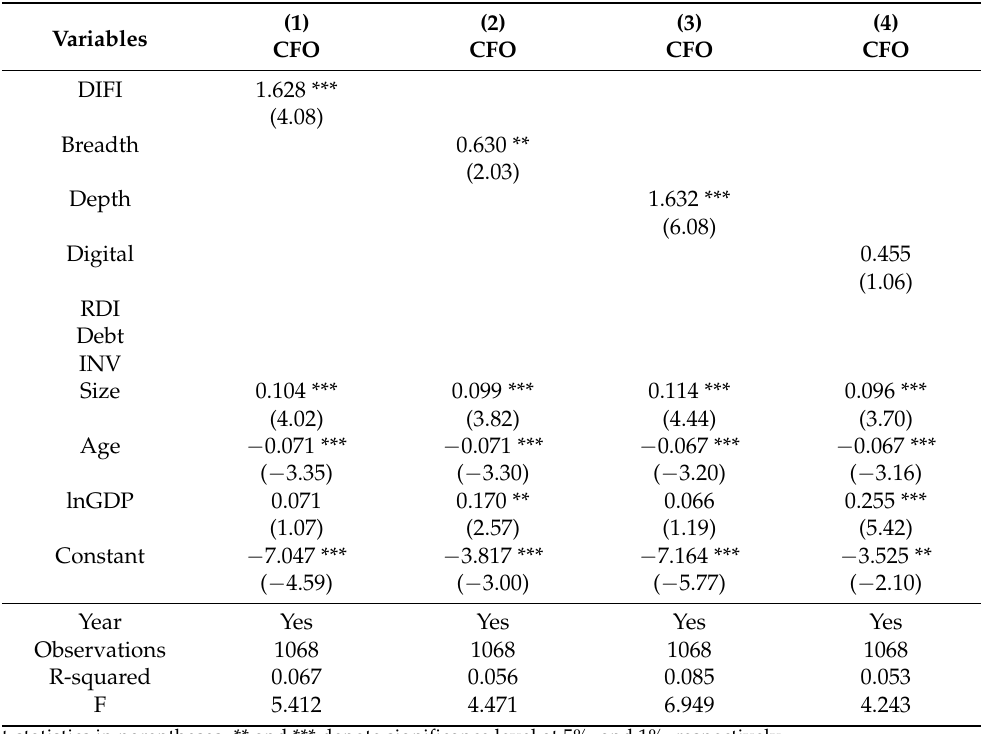
Table 9. Robustness test of digital inclusive finance index and sub-dimensional